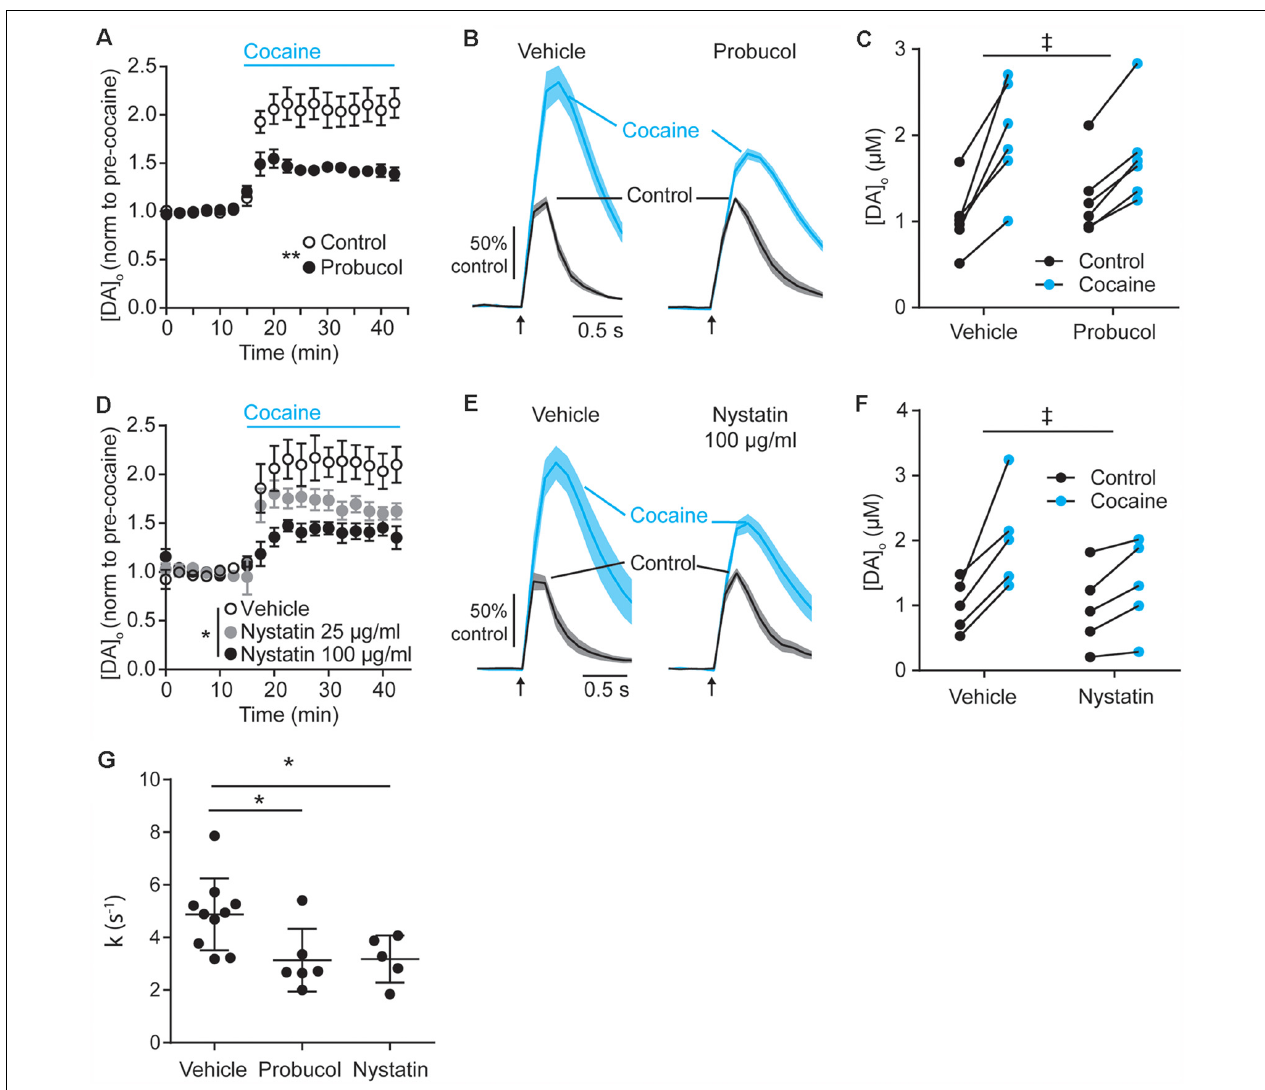
FIGURE 4 | Decreasing extracellular cholesterol in SNCA -OVX striatum decreases DAT control of DA release. (A–D) Mean peak [DA] o ± SEM evoked by 1p vs. time (min) in CPu of SNCA -OVX mice incubated in vehicle control (unfilled circles) or (A) Probucol (black), (D) Nystatin 25 µ g/ml (gray), or 100 µ g/ml (black). Cocaine (5 µ M) added at 12.5 min (blue bar). Two-way ANOVAs: (A) repeated measures for time, time x probucol interaction, F (17,170) = 10.13, P < 0.0001; effect of probucol, F (1,10) = 14.19, ** P = 0.0037. (D) time x nystatin interaction, F (34,204 ) = 4.95, P < 0.0001; effect of nystatin, F (2,12) = 5.98, * P = 0.016. (B–E) Mean [DA] o (normalized to control conditions) ± SEM (shaded) vs. time evoked by single pulses ( arrow ) in CPu of SNCA -OVX mice from slices incubated in vehicle or (C) probucol (5 µ M) or (E) nystatin 100 µ g/ml (thick line) in control condition (black) or with cocaine (blue). (C–F) [DA] o before and after cocaine from slices treated with vehicle and (C) probucol or (F) nystatin 100 µ g/ml. Two-way ANOVA, repeated measures by cocaine treatment: (C) probucol x cocaine interaction, F (1,10) = 6.51, ‡ P = 0.029; (F) nystatin x cocaine interaction, F (1,8) = 7.16, ‡ P = 0.028. (G) Summary of k (s − 1 ) for averaged falling phase transients in vehicle, probucol, or nystatin. One-way ANOVA: